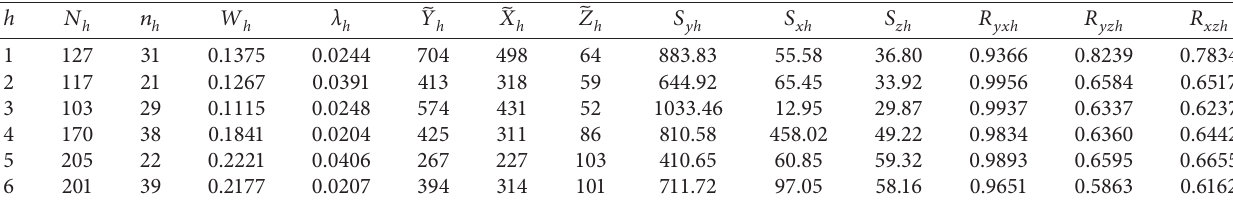
Table 3: Data description of population 1 (scenario II).